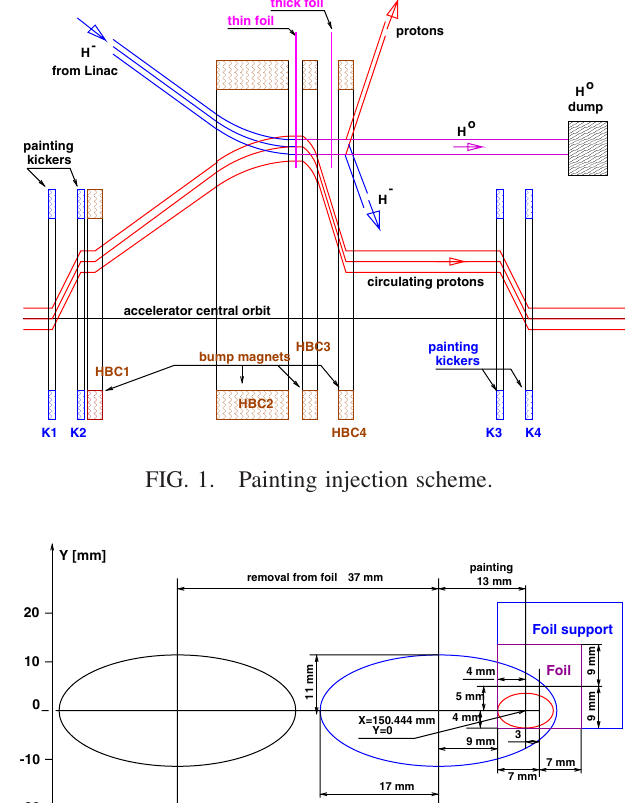
FIG. 2. Injected and circulating beam locations at the 3 - (cid:3) m foil during painting. The transverse dimensions of the foil are 14 mm (cid:3) 18 mm .